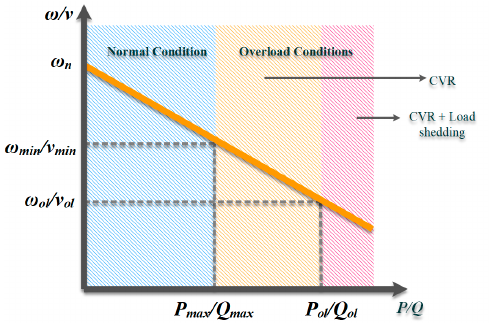
Figure 10. Defined normal and overload regions of droop curves [92].